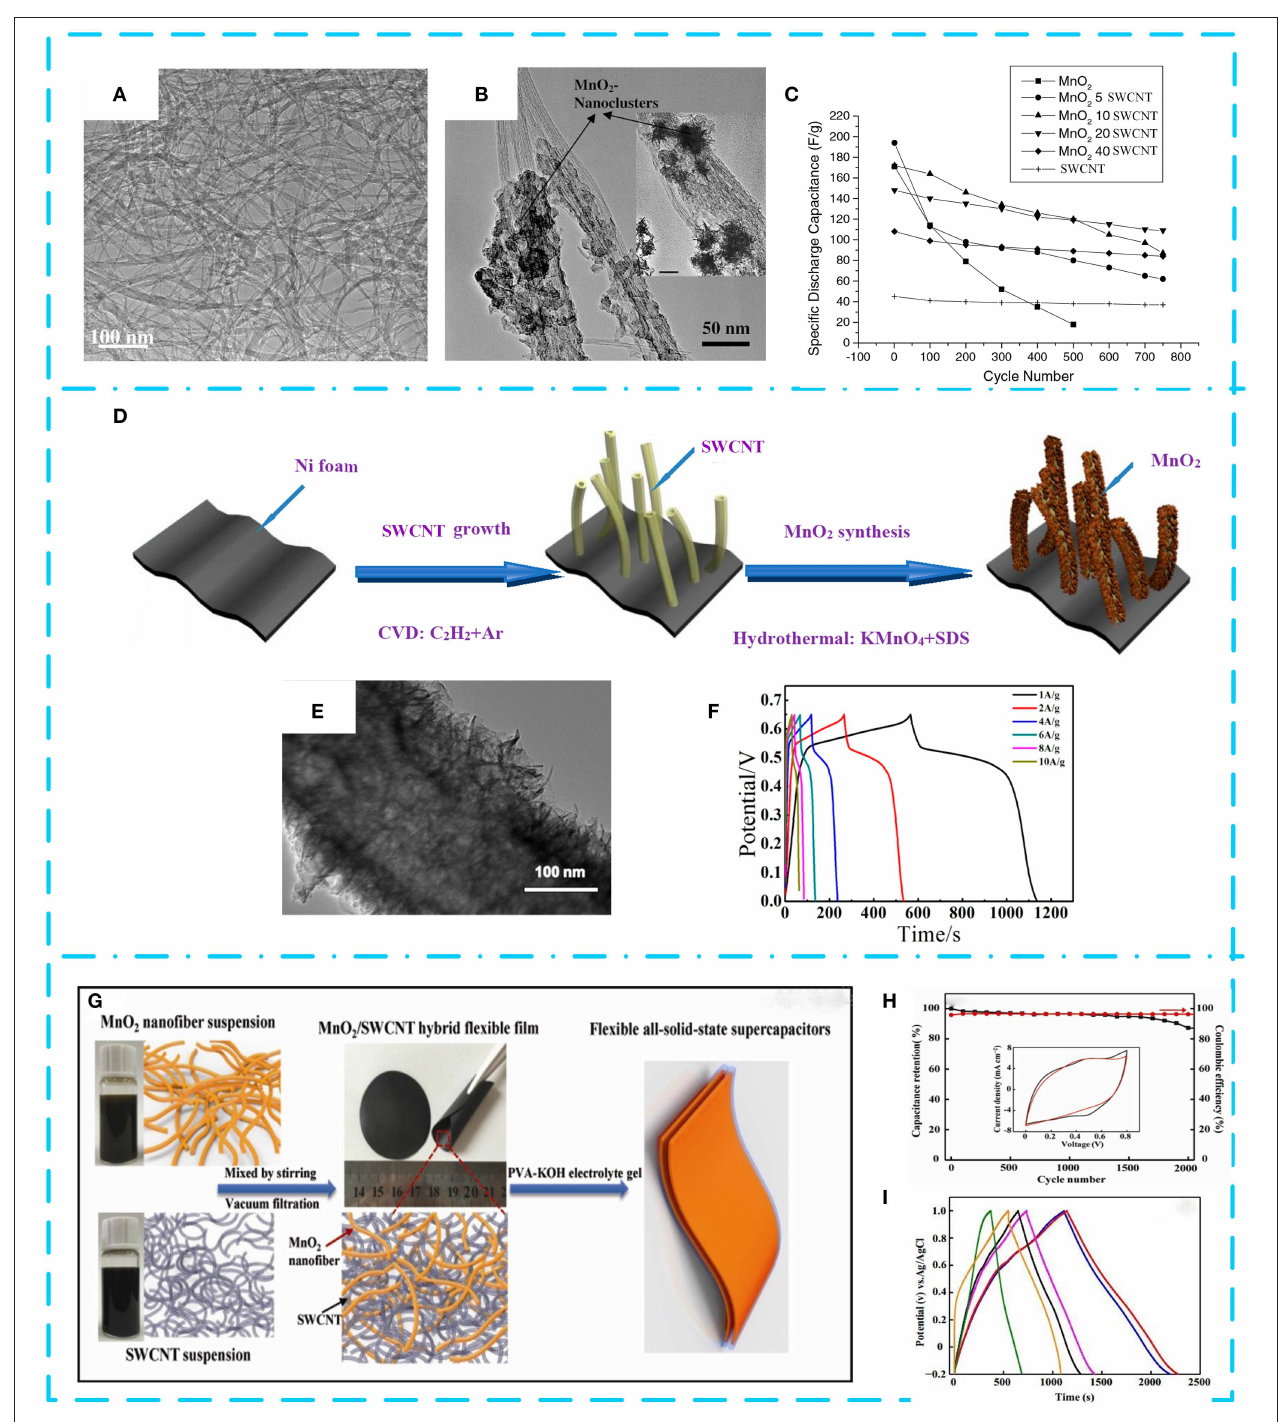
FIGURE 3 | Transmission electron microscopy (TEM) pictures. (A) Pure single-walled carbon nanotube (SWCNT). (B) MnO 2 :20 wt% SWCNT composite. (C) Cyclic voltammograms of pure MnO 2 , pure SWCNT, and MnO 2 :20 wt% SWCNT composite at a scan rate of 2mV s − 1 . Adapted from Subramanian et al. (2006) with permission from Elsevier Inc. (D) Production process of MnO 2 –multi-walled CNT (MWCNT)–Ni foam. (E) MnO 2 synthesized uniformly on MWCNTs. (F) Charge/discharge curves at different current densities of the MnO 2 –MWCNT–Ni foam composite. Adapted from (Li L. et al., 2019) under the Creative Commons CC license. (G) Schematic preparation representation of the flexible all-solid-state δ -MnO 2 /SWCNT hybrid supercapacitor. (H) Cyclic voltammetry curves from 5 to 100mV s − 1 . (I) Galvanostatic charge/discharge (GCD) curves of MnO 2 /SWCNT composites at a current density of 0.1mA cm − 2 in a 1M Na 2 SO 4 electrolyte. Reproduced from Wang L. et al. (2017) with permission from the Royal Society of